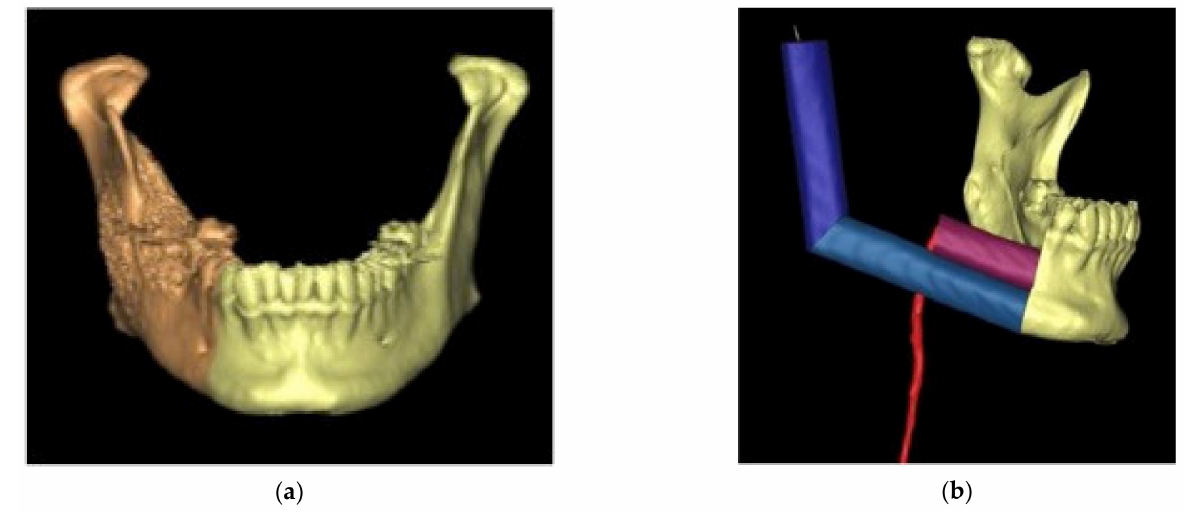
Figure 2. ( a , b ): Virtual surgical planning on CT images.